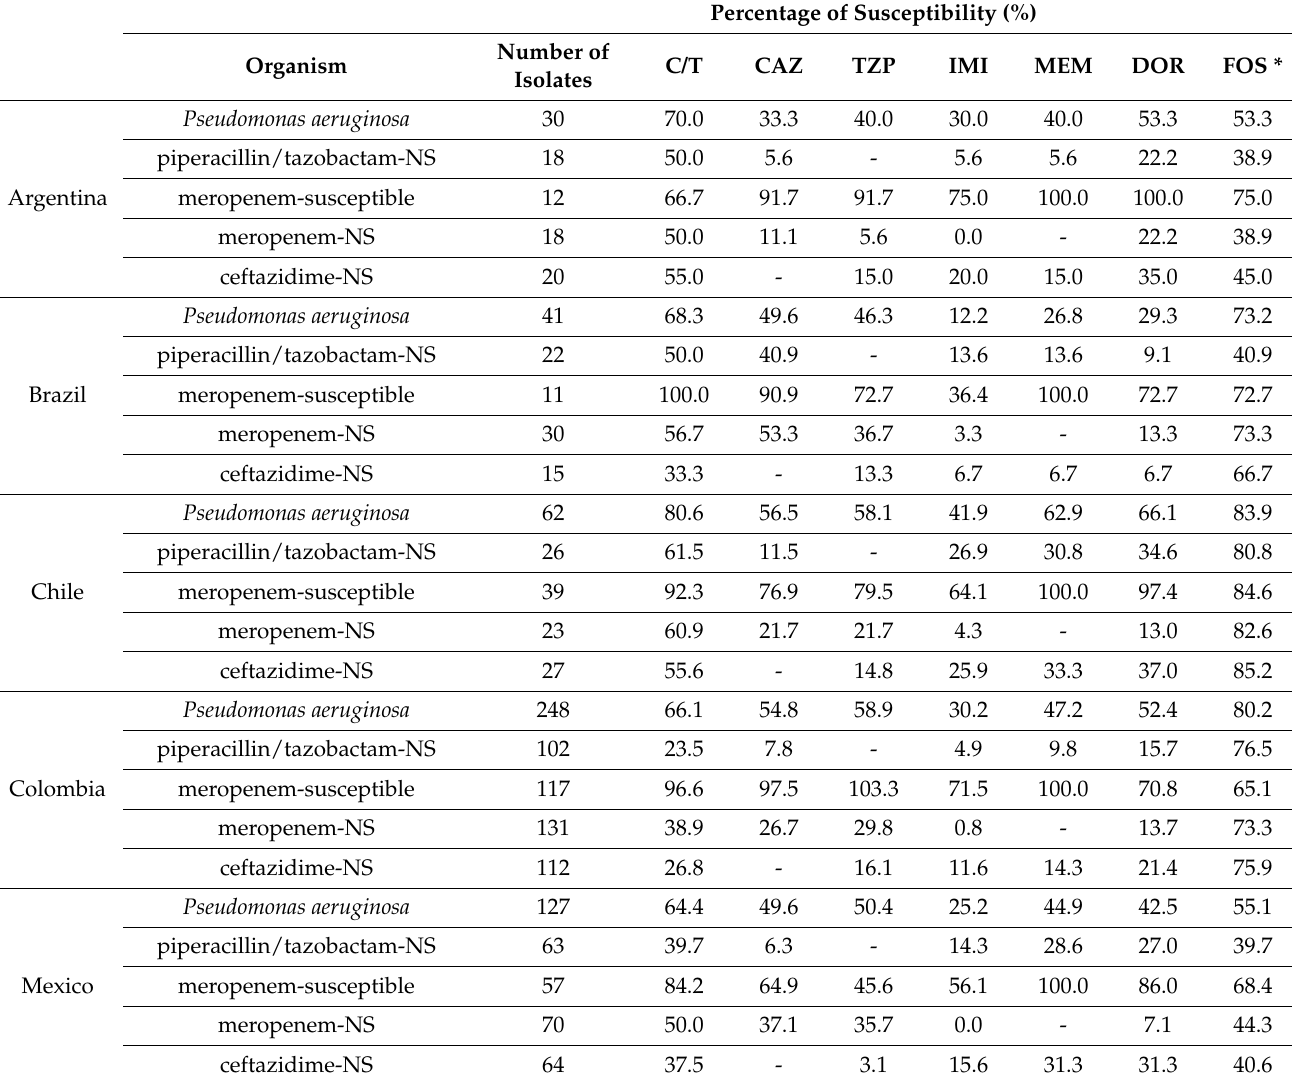
Table 2. Susceptibility of P. aeruginosa clinical isolates and phenotypic subsets to C/T and comparator agents between 2016 and 2017 from five Latin American